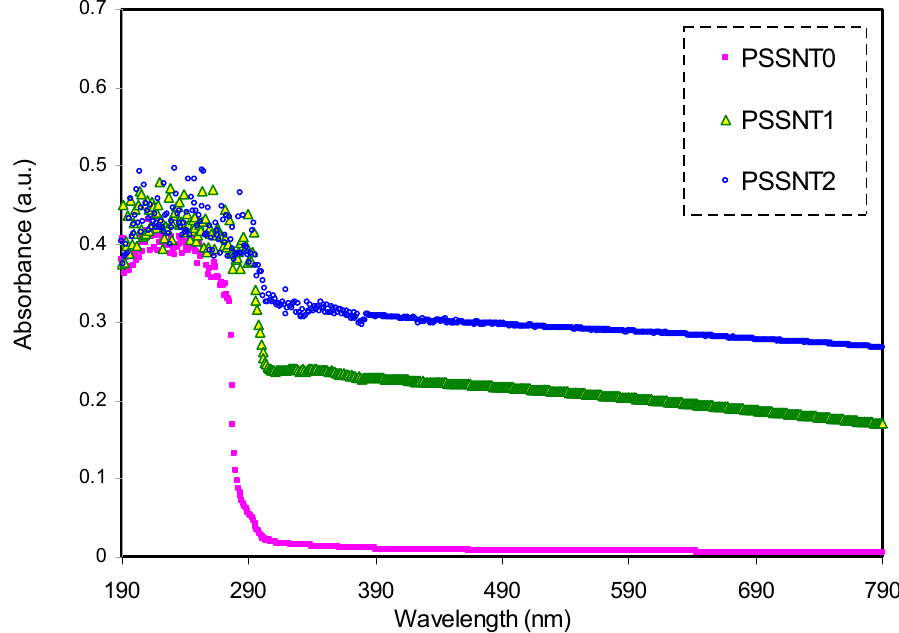
Figure 3. Absorption spectra of pure PS (PSSNT0), PSSNT1, and PSSNT2 nanocomposite films.